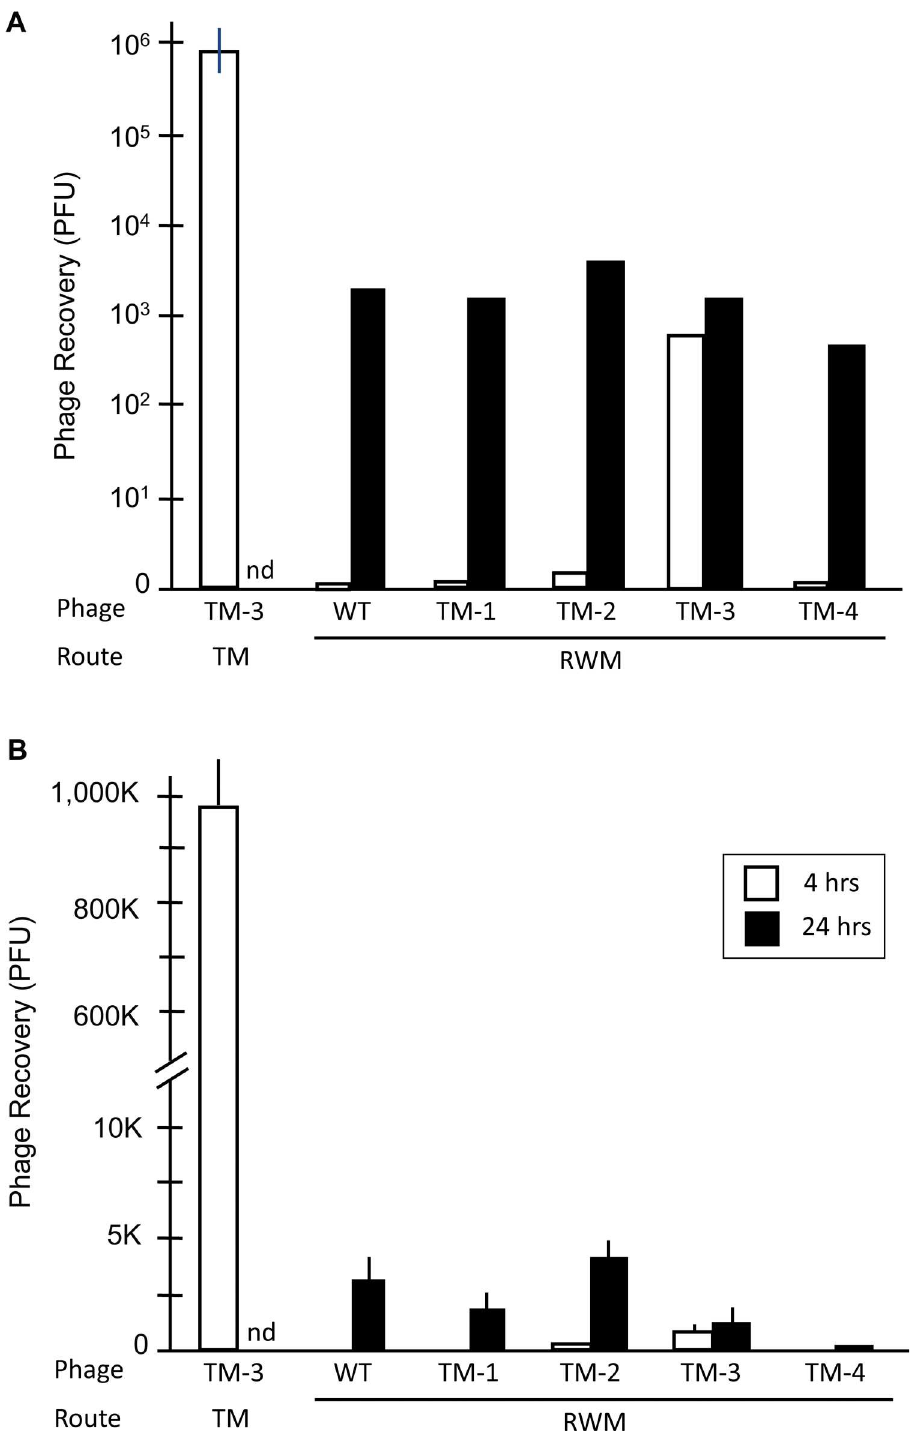
Fig 7. Comparison of trans-TM peptide entry into the IE versus the ME. Comparedto ME recovery of TM-3 after 4-hr applicationof 10 9 phage to the TM (white bar, taken from Fig 1), recovery of TM-transiting phage from perilymph, 4 hrs after instillationof 10 9 phage onto the area of the RWM (black bars) is absent or very low. Phagerecovery from the IE improvedsomewhatat 24 hrs, but was not greater for TM-transiting phage than for WT Phage not bearinga peptide. Thus, any movement of phage into the IE does not appearto be peptide-mediated. Error bars = SD (n = 4).